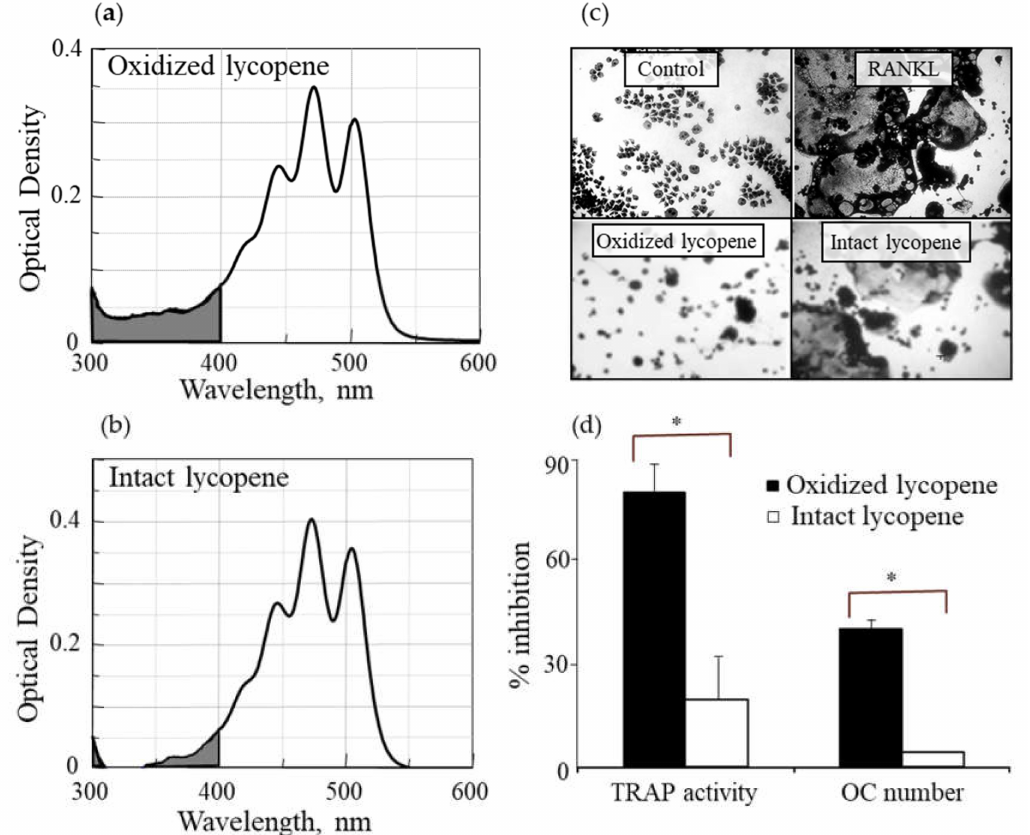
Figure 1. Oxidized lycopene inhibits osteoclast di ff erentiation. Characteristic absorption spectrum of the oxidized lycopene ( a ) and intact lycopene ( b ) used in the experiment. ( c , d ) RAW264.7 cells (4 × 10 4 cells / well) were incubated either alone or in the presence of RANKL (20 ng / mL) without lycopene or with one of its two types at a concentration of 10 µ M. ( c ) Photographs of cells after staining for tartrate resistant acid phosphatase- (TRAP)-positive cells (original magnification × 100). ( d ) Counting of multinucleated TRAP-positive cells and measurement of TRAP activity. Values are the means ± SD of three experiments, each performed in triplicate. * p < 0.01 for the di ff erence between the % inhibition with oxidized lycopene vs. intact